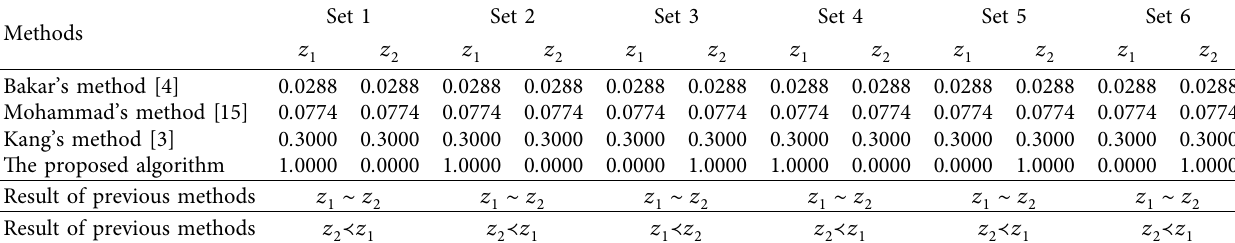
Table 1: A comparison between the rankings of previous